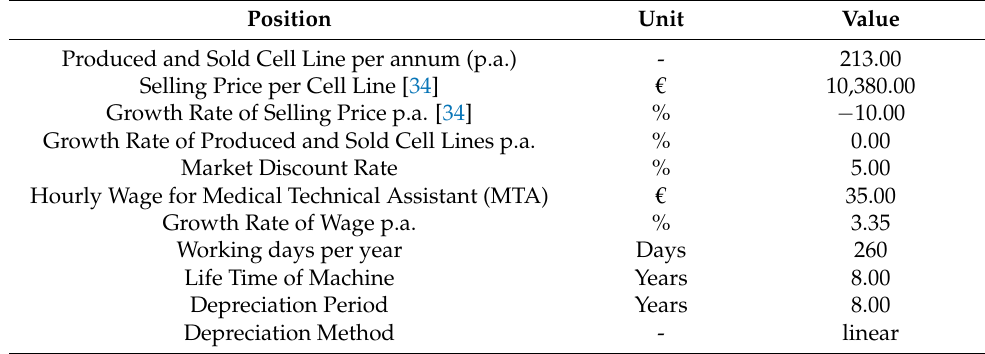
Table 1. Key assumptions for economic analysis of manual and automated iPSC production. Position Unit Value Produced and Sold Cell Line per annum (p.a.) Growth Rate of Selling Price p.a. [34] Growth Rate of Produced and Sold Cell Lines